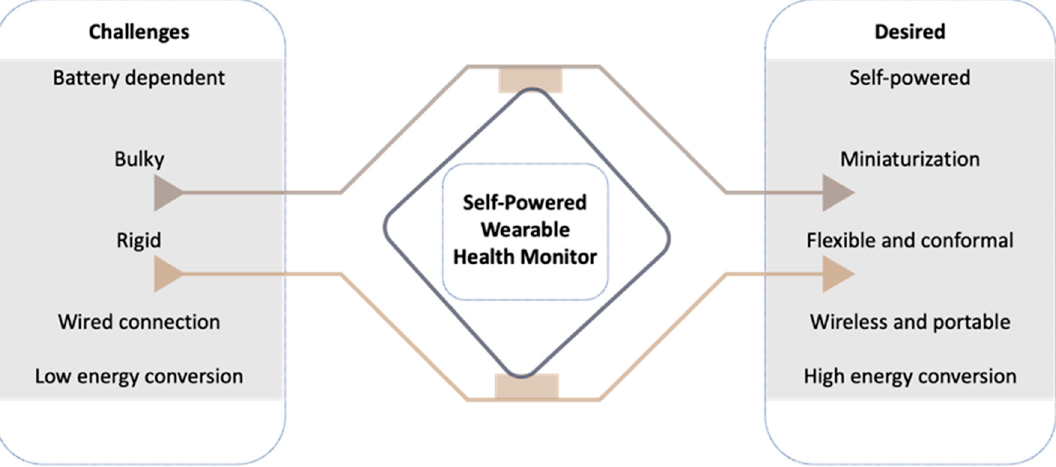
Figure 11. A brief overview of challenges and future perspectives for self-powered health monitor- ing systems.